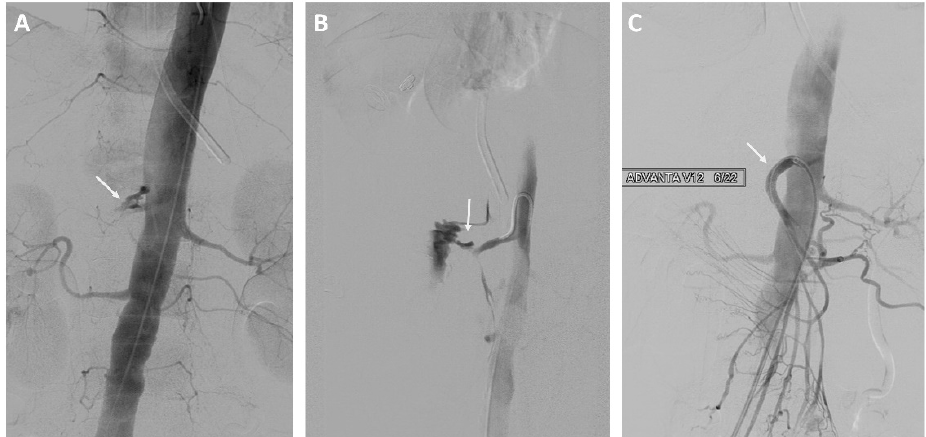
Figure 1. A 61-year-old man with a history of pancreatic head adenocarcinoma and pylorus pre- serving pancreatoduodectomy (PPPD). ( A ) Angiography showing bleeding from the gastroduode- nal artery stump and the hepatic artery. ( B ) Treatment of the hepatic artery with a stent-graft.